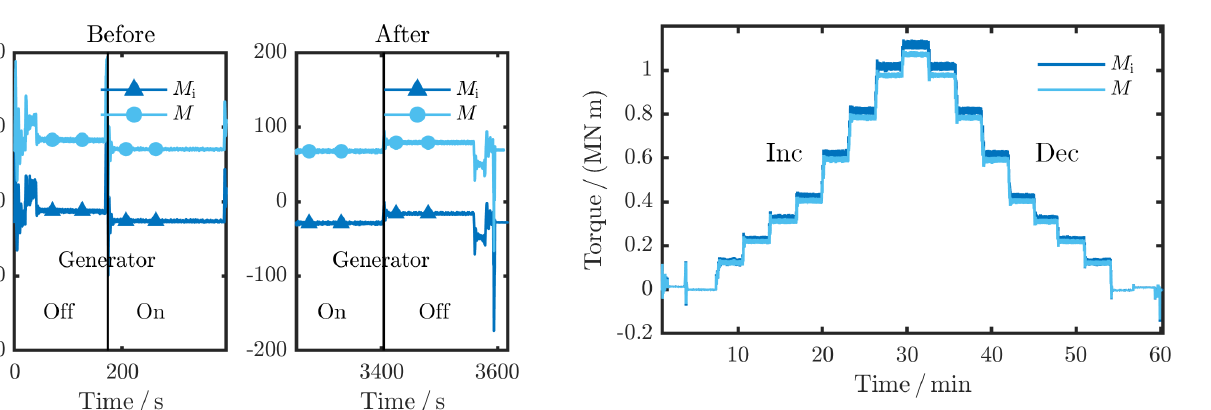
Figure 4. Zero signal determination under constant minimum rota- tion before and after each load cycle.